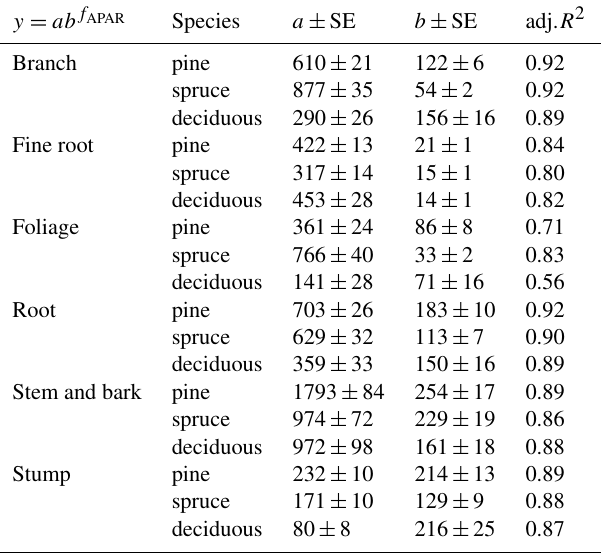
Table B1. Parameter estimates and their standard errors for the co- efficients of the dry weight biomass (kgha − 1 ) models with the frac- tion of absorbed radiation ( y = ab f APAR ) for Scots pine, Norway spruce, and deciduous